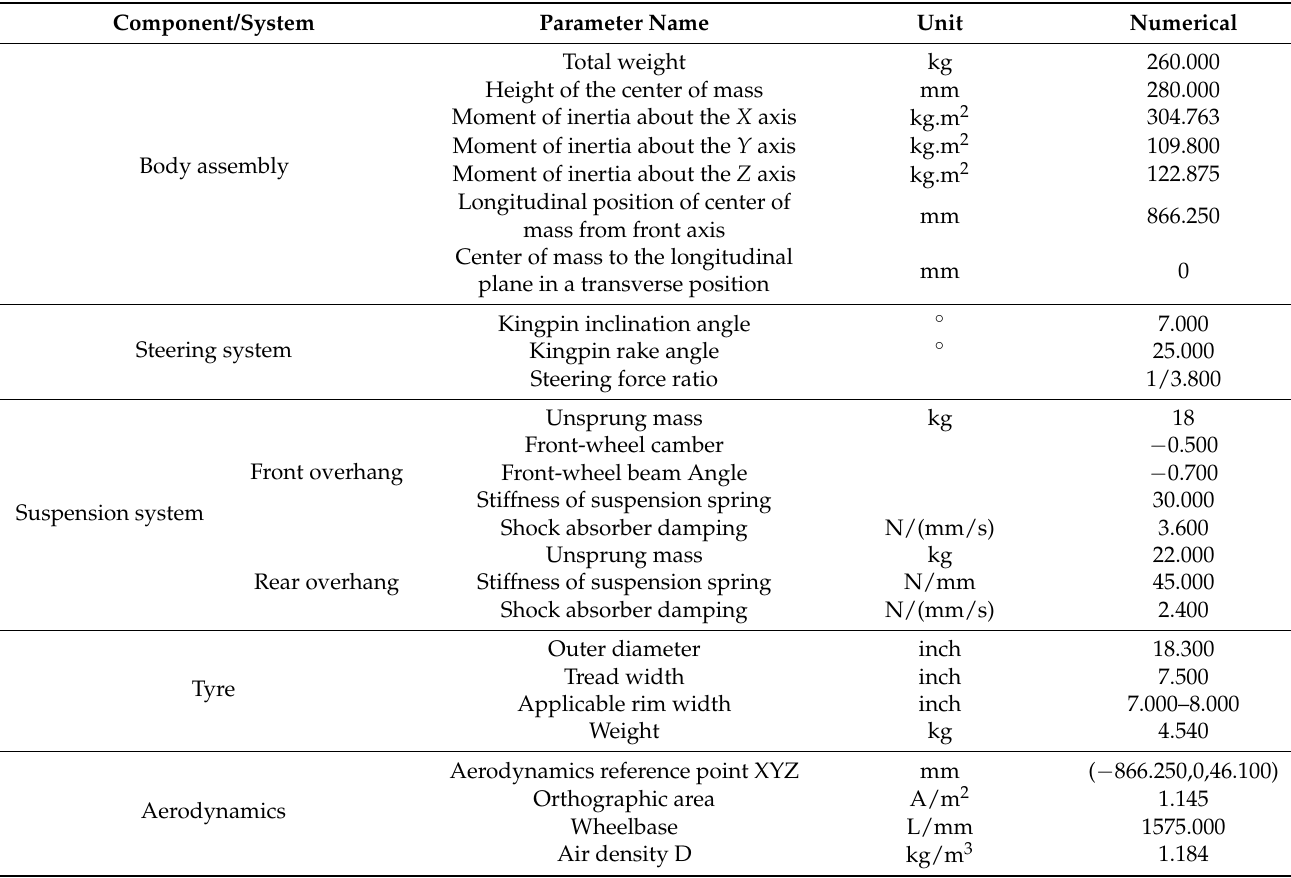
Table 7. Parameters of dynamic simulation model.